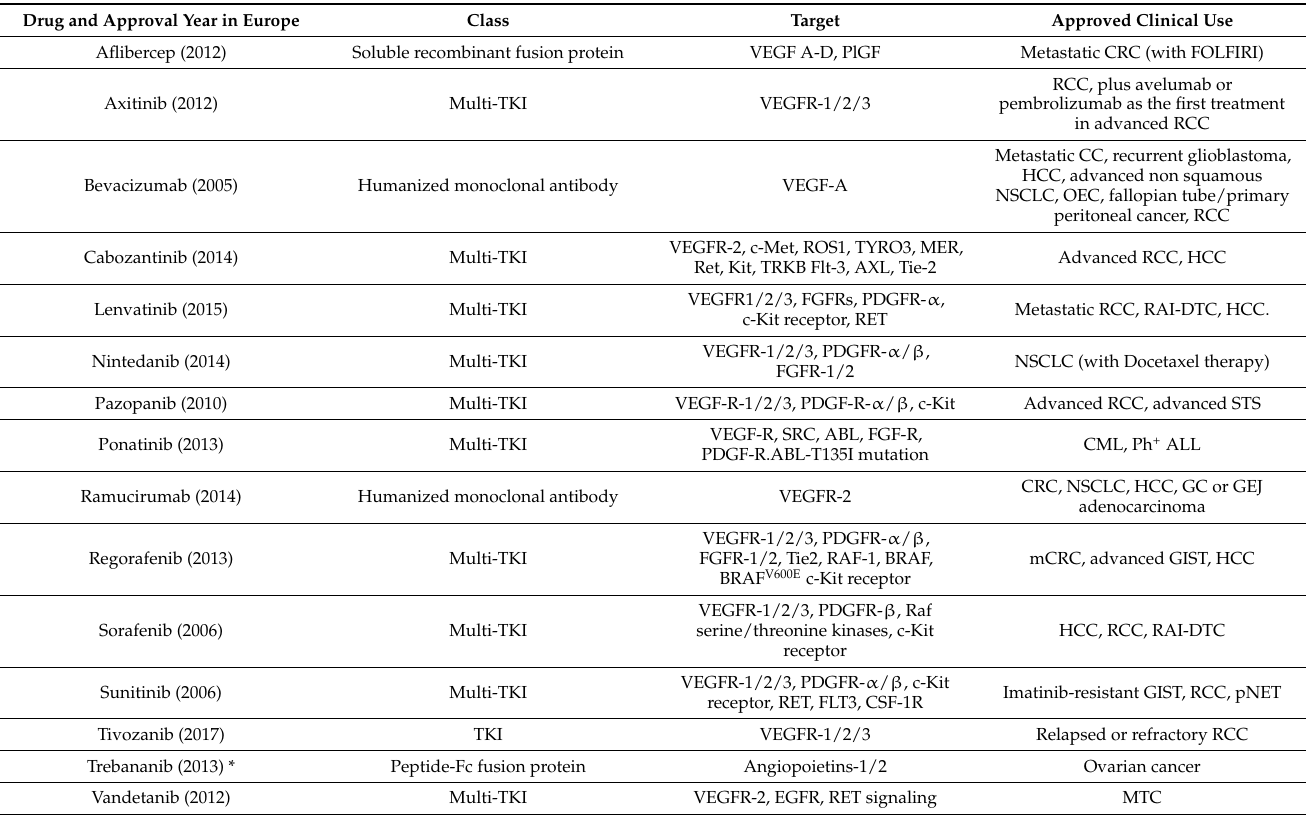
Table 1. Approved drugs with anti-angiogenic properties (known/potential) in patients with solid